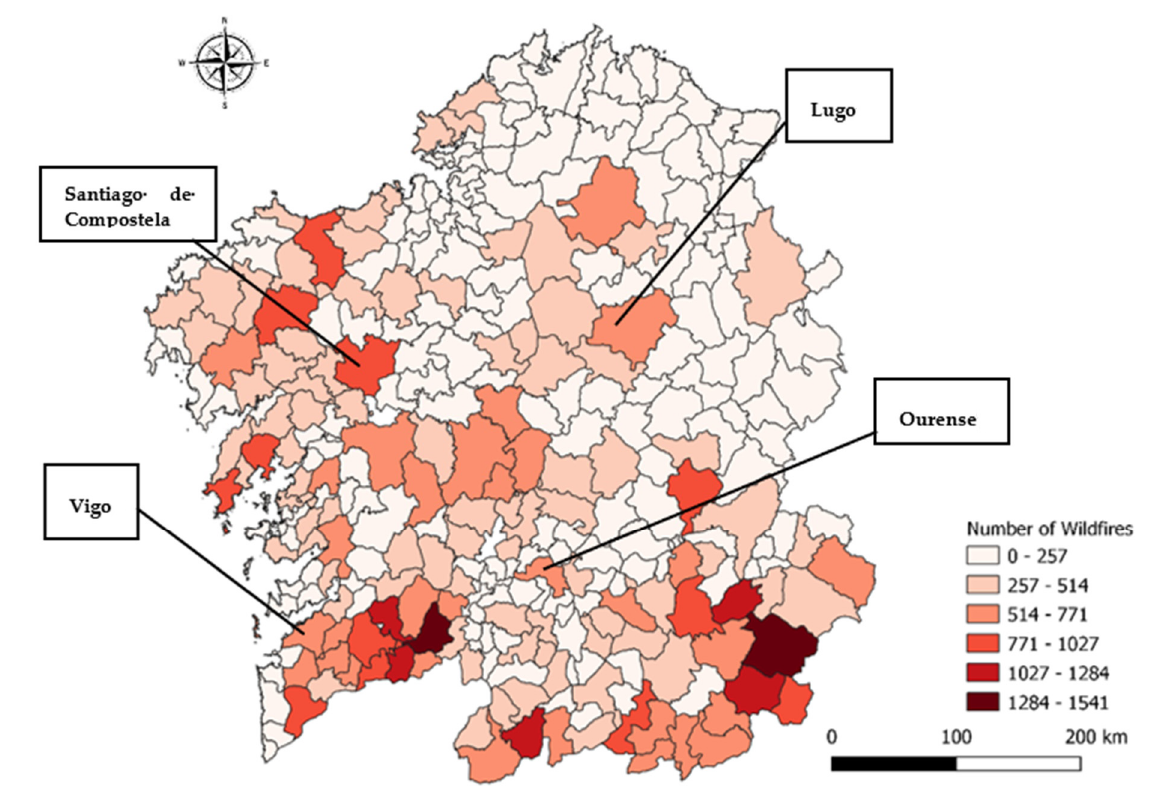
Figure 1. Number of wildfires in Galician municipalities within the first 15 years of the 21st century. Galicia has 2,060,453 hectares of forest that cover 69% of the area of the region, 31% of which are non-forestry areas between scrubs and pasture. The forest produces, in most years, about 50% of Spain’s timber and about 4.5% of the European Union’s timber. Forest territories are divided chiefly among small owners, agricultural use, and a mixture of farmed and forested lands. Additionally, over the past 40 years, there has been an abandonment of rural activities due to a decrease in the rural population and the resultant thinning of population density [42].